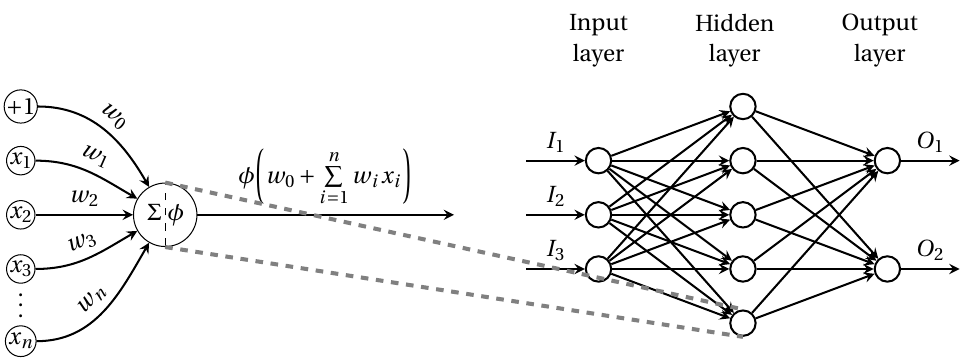
Figure 3. A multi-layer perceptron with one input layer, one hidden layer and one output layer. Diagram adapted from https://github.com/PetarV-/TikZ, accessed on 10 May